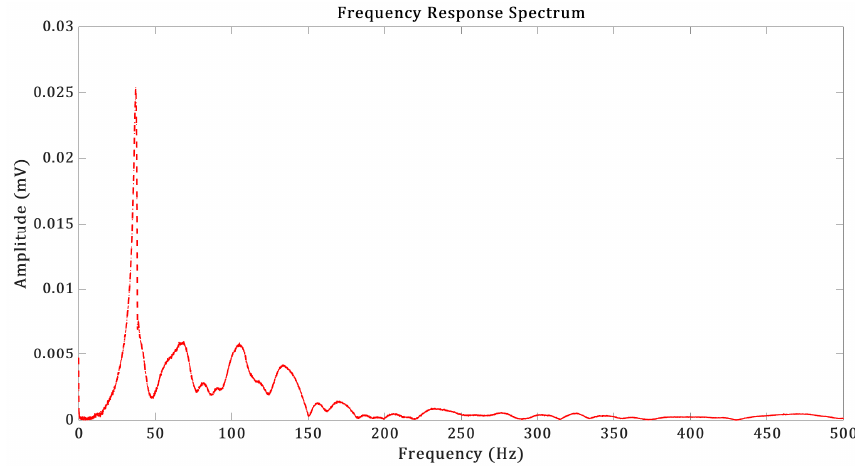
Figure 7. Typical frequency response spectrum for MLM4.